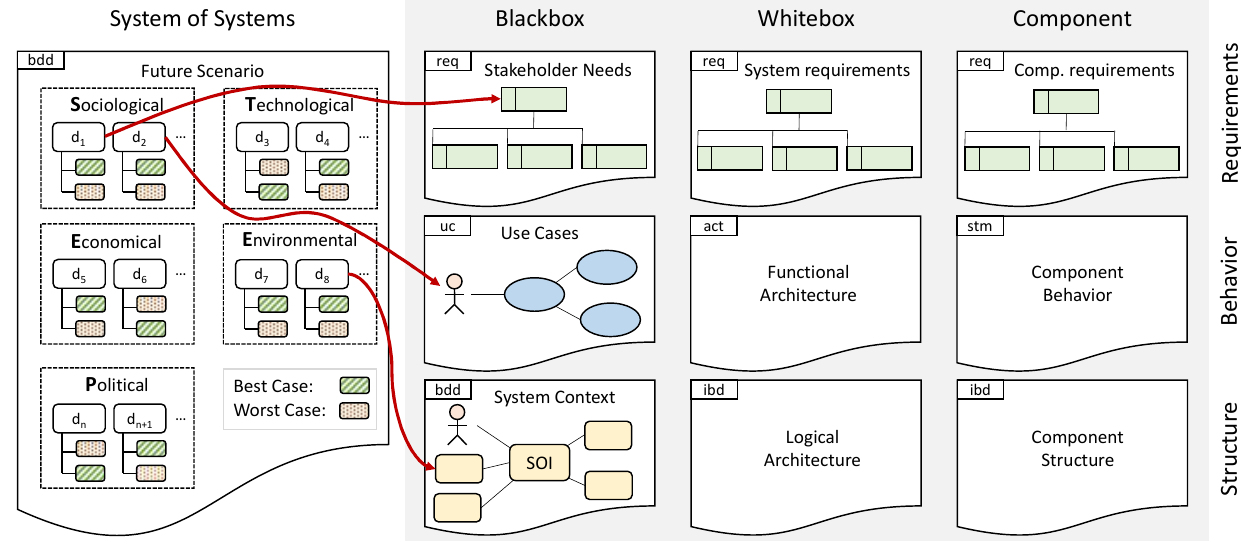
Figure 1. System model and impacts of the future scenario.